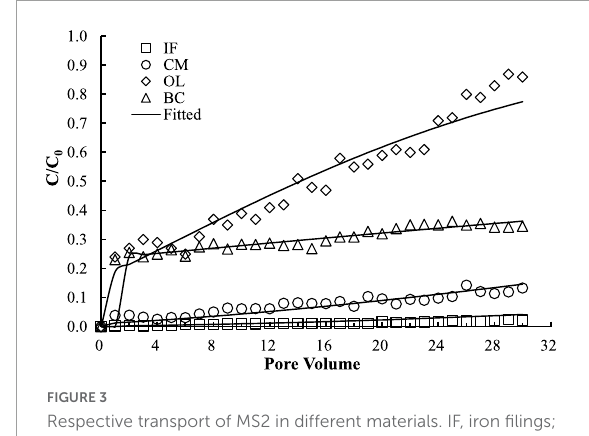
FIGURE2 Respective transport of E. col i 652T7 in different materials. IF, iron filings; CM, calcined magnesite; OL, natural ore limestone; BC, corn stalk biochar. The lines are the modeling results with advection-dispersion equation using the Hydrus-1D software.